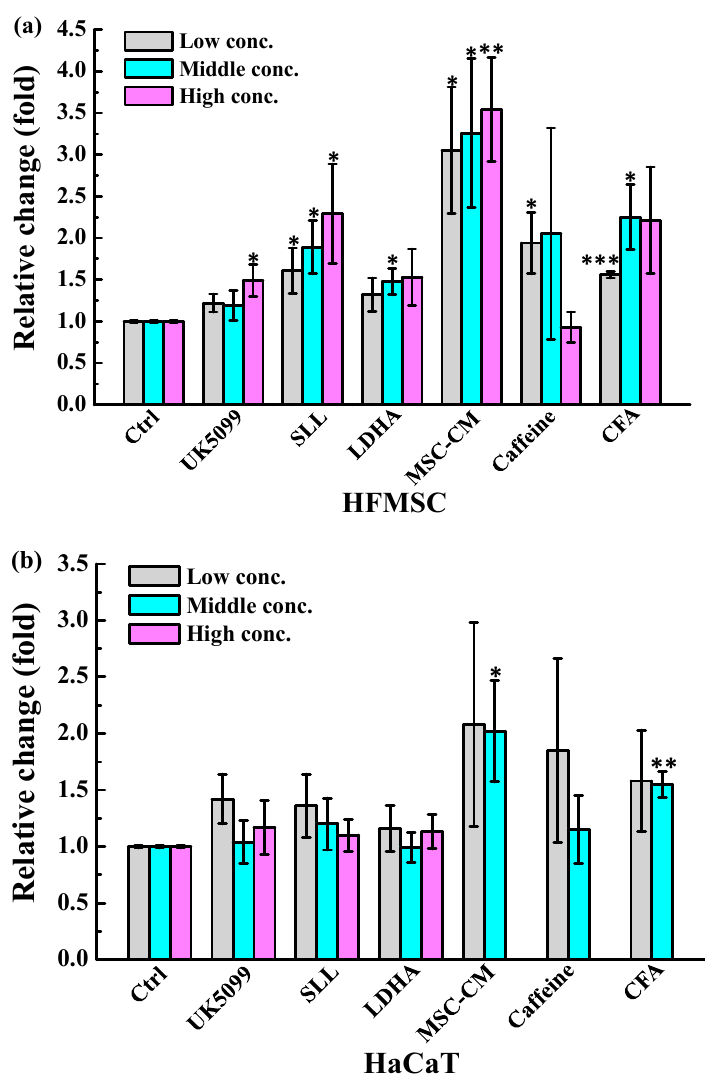
Figure 4. The statistical analysis of Ki-67 expression in ( a ) HFMSC and ( b ) HaCaT treated with UK5099, SLL, LDHA, MSC-CM, caffeine, and CFA in certain concentrations (* p < 0.05 and ** p < 0.01).